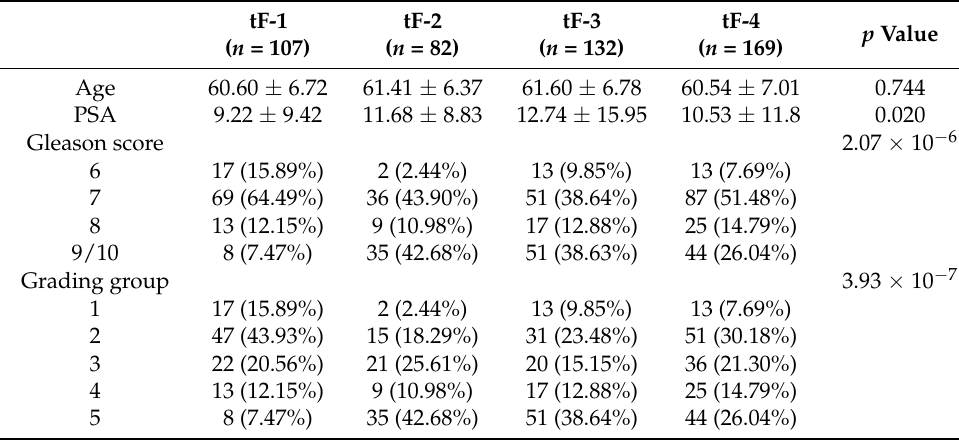
Table 1. Clinicopathological features of four tRF subtypes of